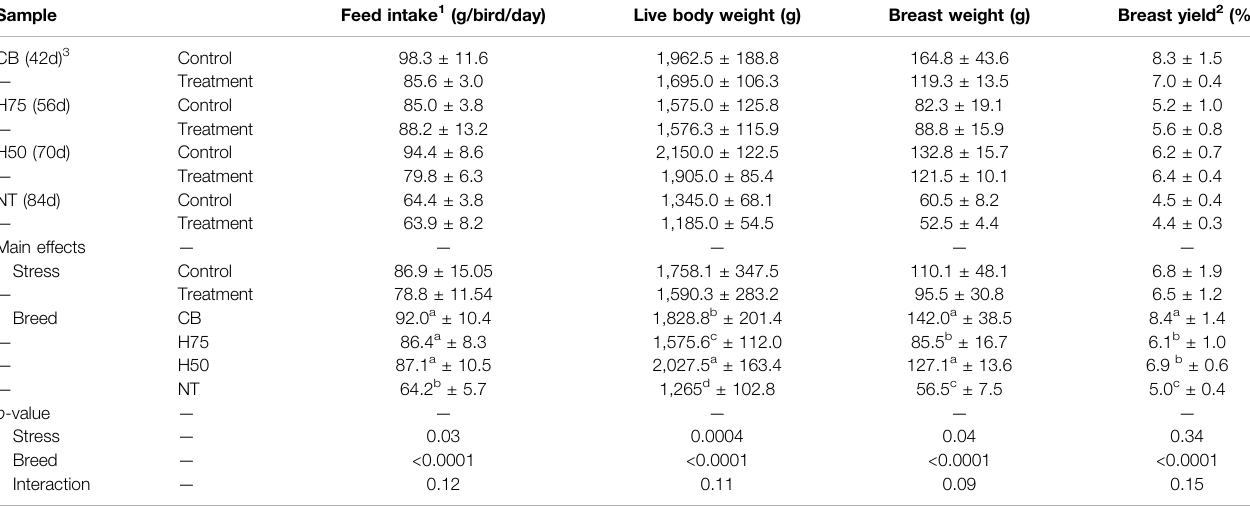
TABLE 3 | Live body weight at slaughter age, breast weight, and breast yield (%) of the chicken samples.